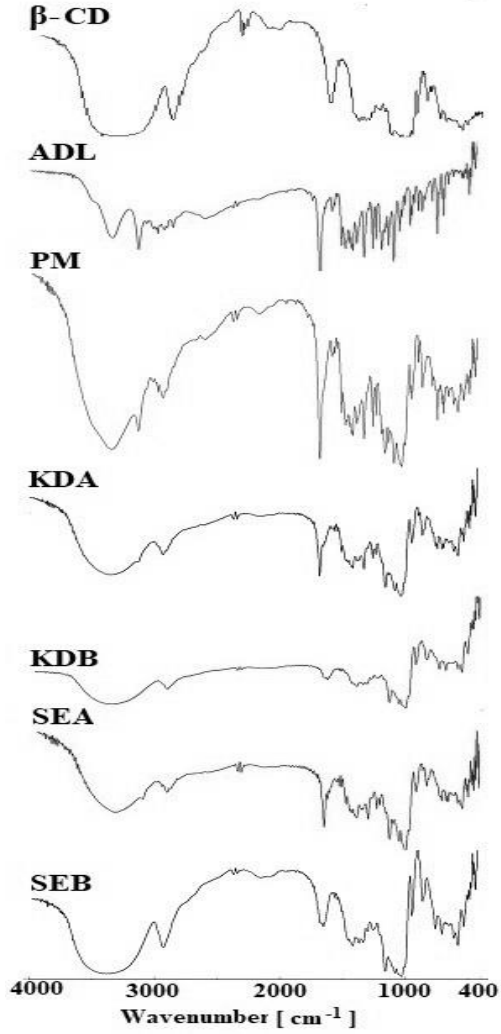
Figure 4. Comparative FTIR spectra of pure ADL and the binary and ternary complexes. Arbidol (ADL); physical mixture (PM); binary kneaded ADL/ β -CD (KDA); ternary kneaded ADL/ β -CD with 1% poloxamer 188 (KDB); binary solvent evaporated ADL/ β -CD (SEA); ternary solvent evaporated ADL/ β -CD with 1% poloxamer 188